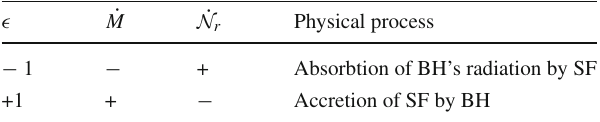
Table 4 BH and its surrounding radiation field parameters for (cid:5) = ±